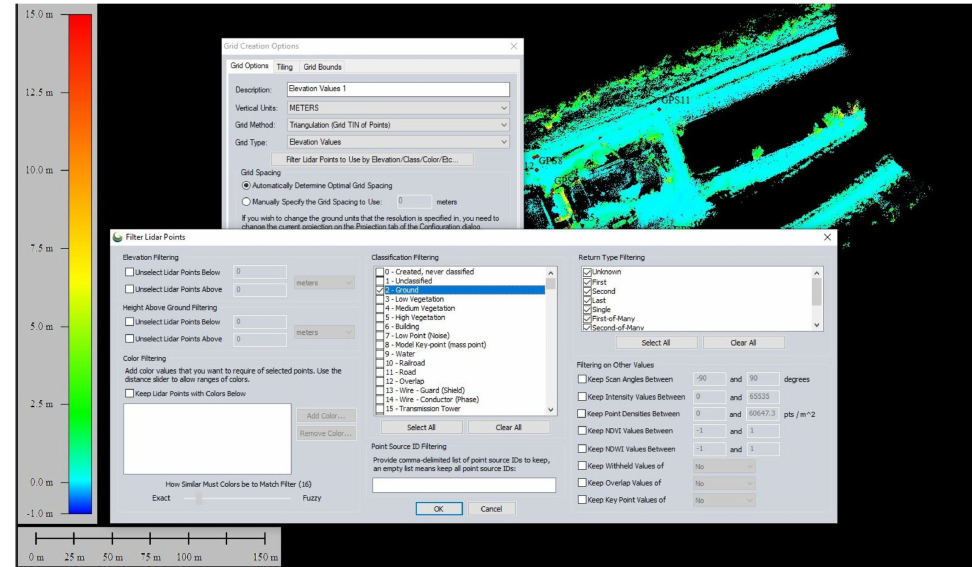
Figure 13. DSM generated by photogrammetric